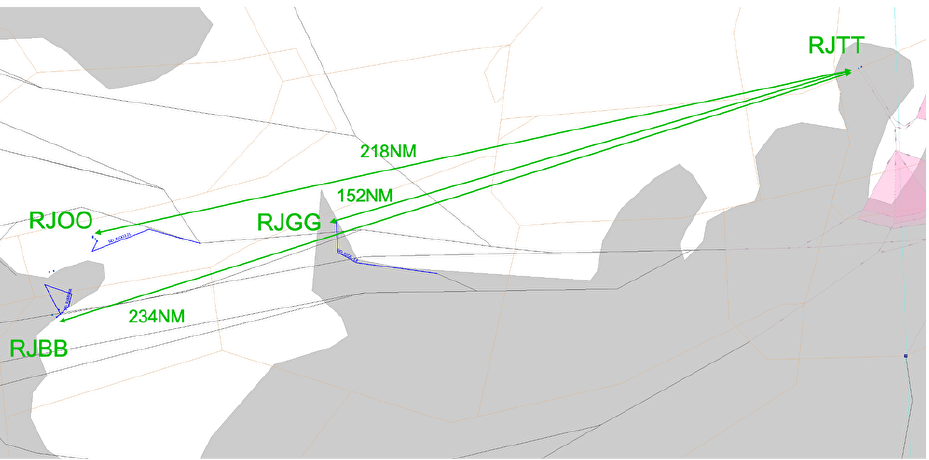
Figure 11. Distance from Tokyo International Airport (RJTT) ( green lines ) and Standard Instrumental Departures (SIDs) ( blue lines ) for Osaka International Airport (RJOO), Kansai International Airport (RJBB) and Chubu International Airport